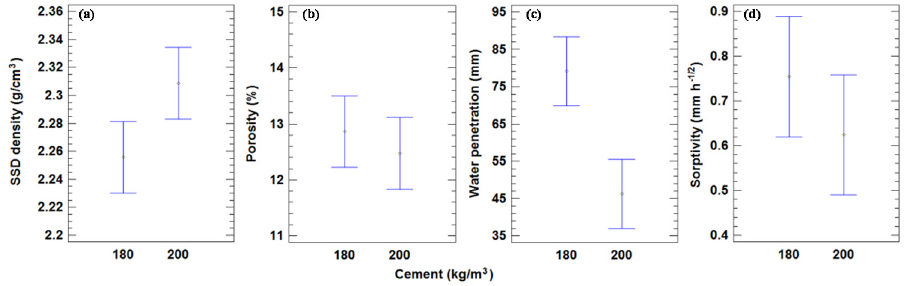
Figure 5. ( a ) Mean values of SSD density and 95% LSD intervals vs. amount of cement. ( b ) Mean values of porosity and 95% LSD intervals vs. amount of cement. ( c ) Mean values of water penetration and 95% LSD intervals vs. amount of cement. ( d ) Mean values of sorptivity and 95% LSD intervals vs. amount of cement.